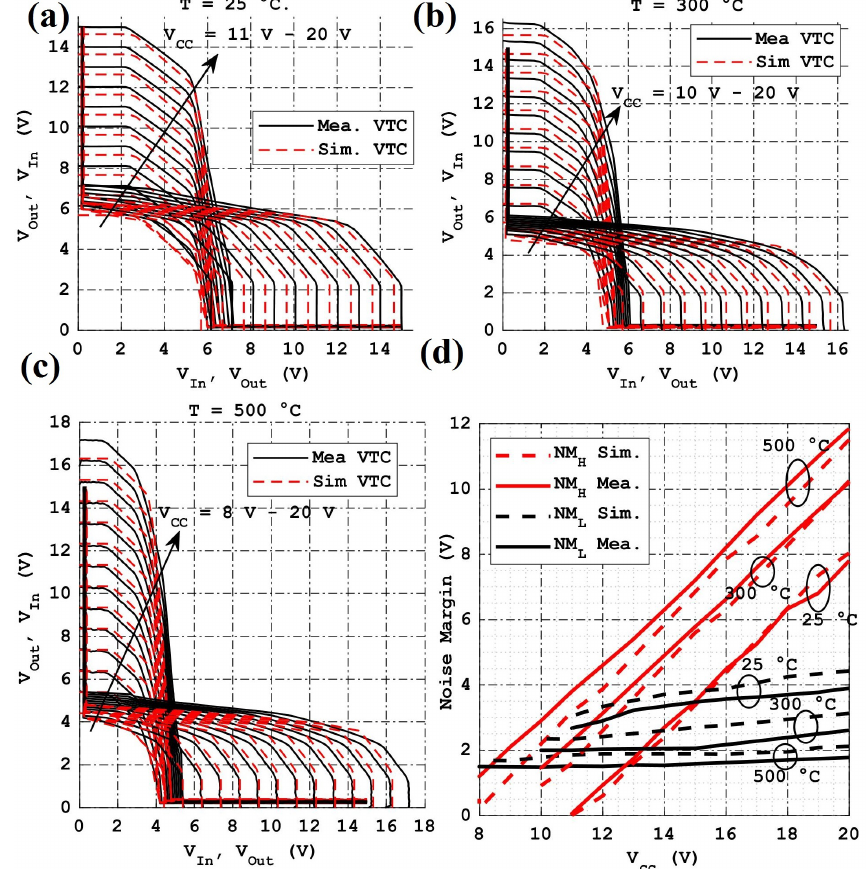
Figure 12. SiC TTL inverter simulated vs. measured VTC & noise margins as supply-voltage rises from 8 to 20 V at three discrete temperatures i.e., T = 25 ○ C, T = 300 ○ C and T = 500 ○ C ( a ) simulated vs. measured VTC at T = 25 ○ C ( b ) simulated vs. measured VTC at T = 300 ○ C ( c ) simulated vs. measured VTC at T = 500 ○ C ( d ) simulated vs. measured noise margins as the supply-voltage rises from 8 to